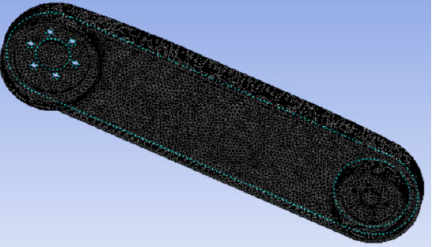
Figure 5. Finite element analysis model of the big arm.